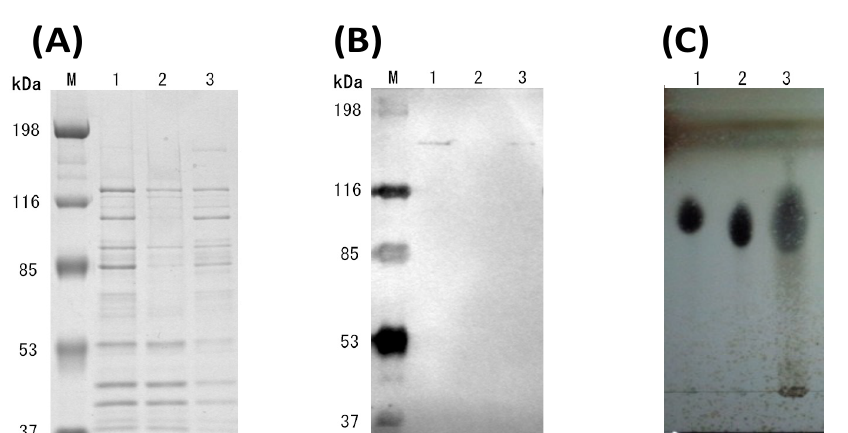
Figure 2. Analyses of the culture supernatant of C. cellulovorans with shredded paper. ( A ) SDS-PAGE and ( B ) Western blot analysis using an anti-CbpA antibody (1:2000 dilution). Lane M, molecular mass marker; lane 1, culture supernatant; lane 2, non-adsorption fraction against shredded paper; and lane 3, adsorption fraction against shredded paper. ( C ) TLC analysis. Lane 1, glucose (G1); lane 2, cellobiose (G2); and lane 3, culture supernatant.